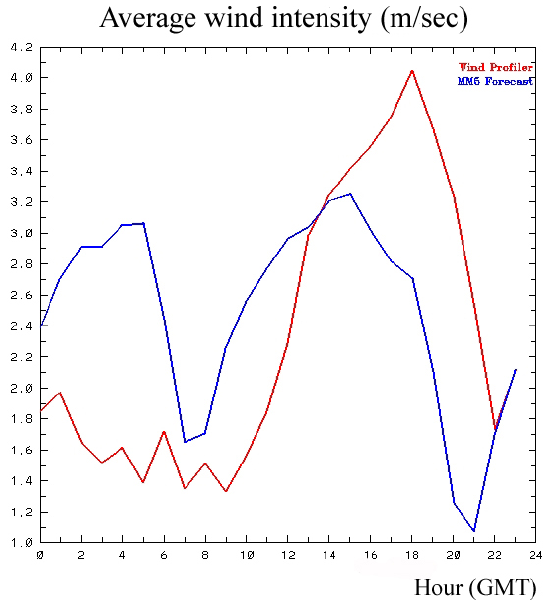
Fig. 10. Comparison between average wind intensity, of near-surface winds, observed by the radar wind profiler (red line) and predicted by MM5 (blue line).